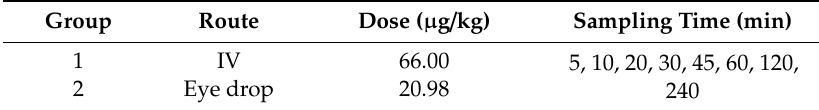
Table 6. Experimental design of PK studies in